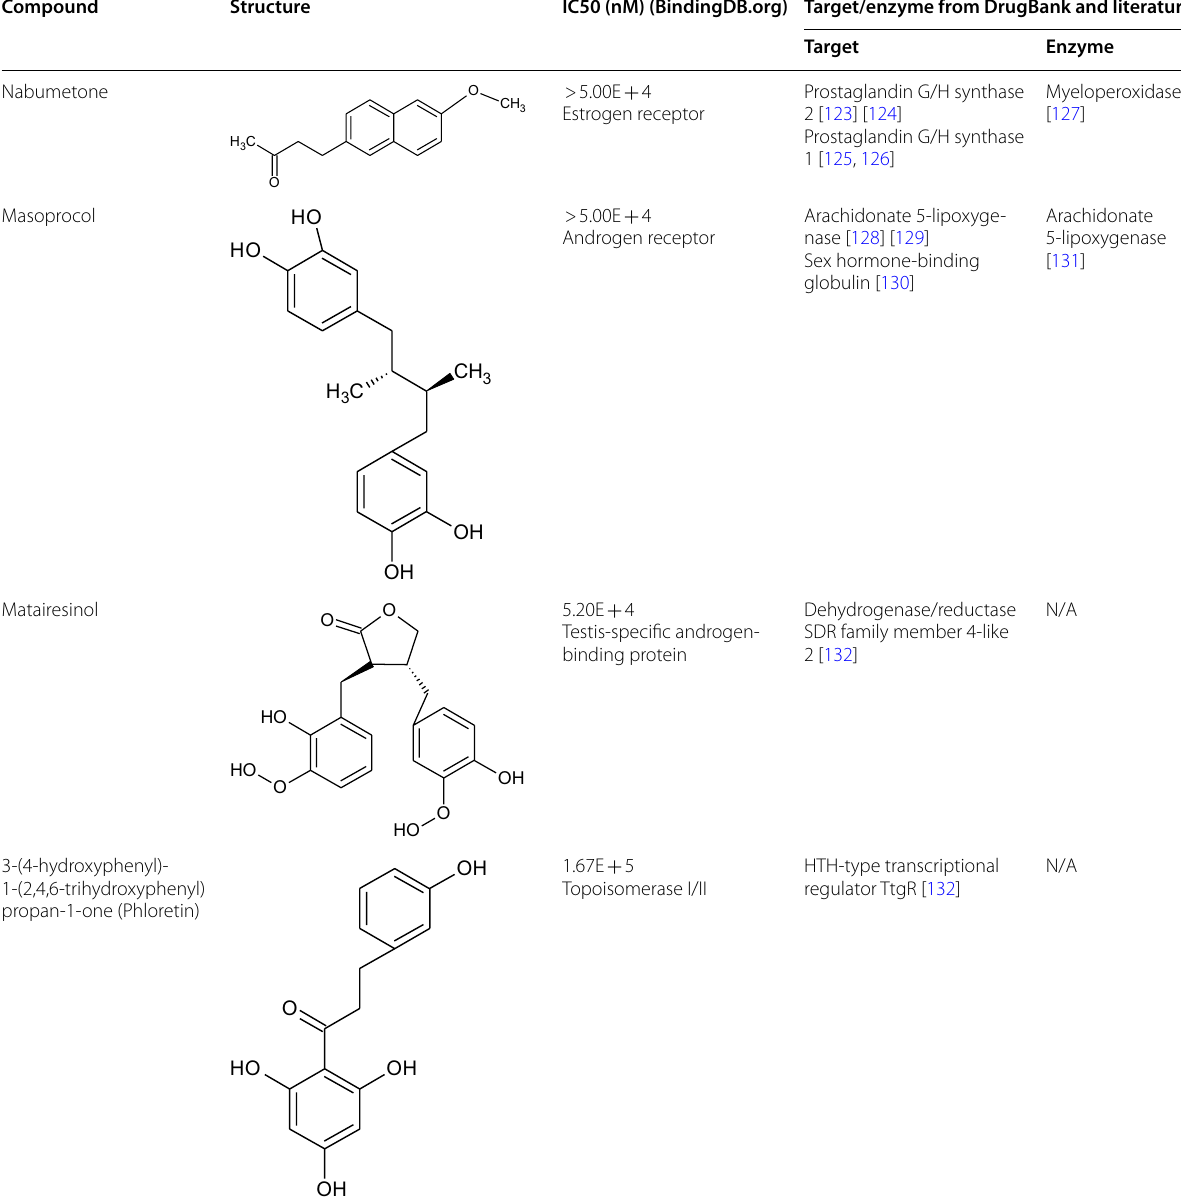
Table 3 Structure activity relationships of similar compounds and their targets/enzymes